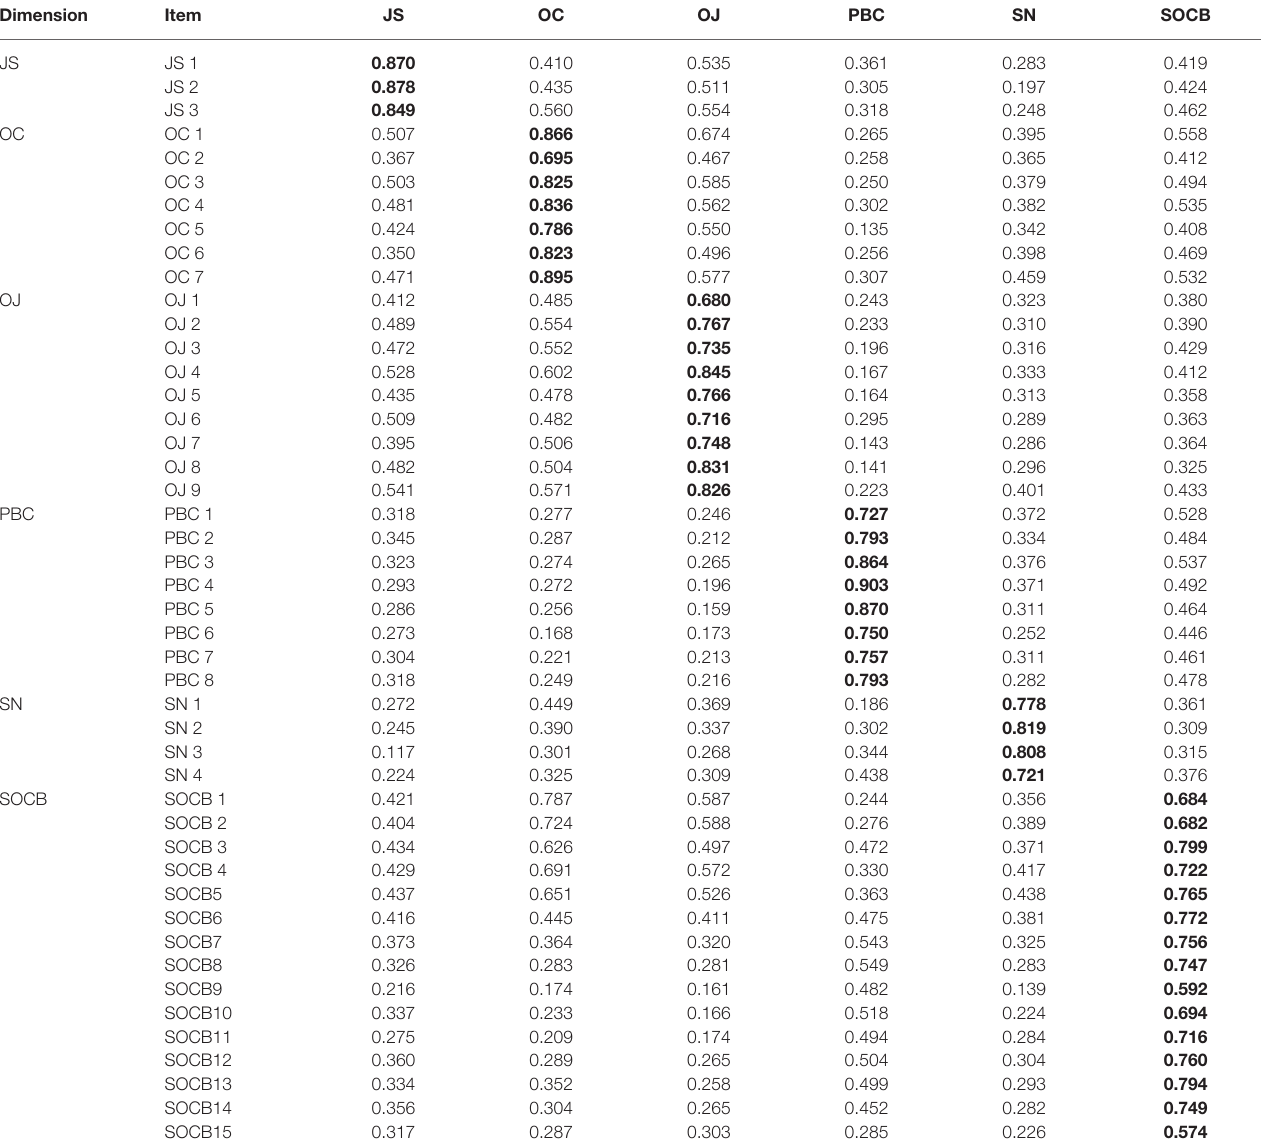
TABLE 5 | Cross loadings. Dimension